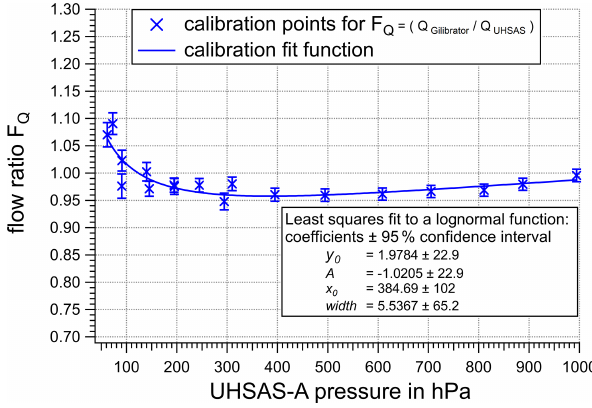
Figure A2. Sample flow characterization measurements as a func- tion of pressure.